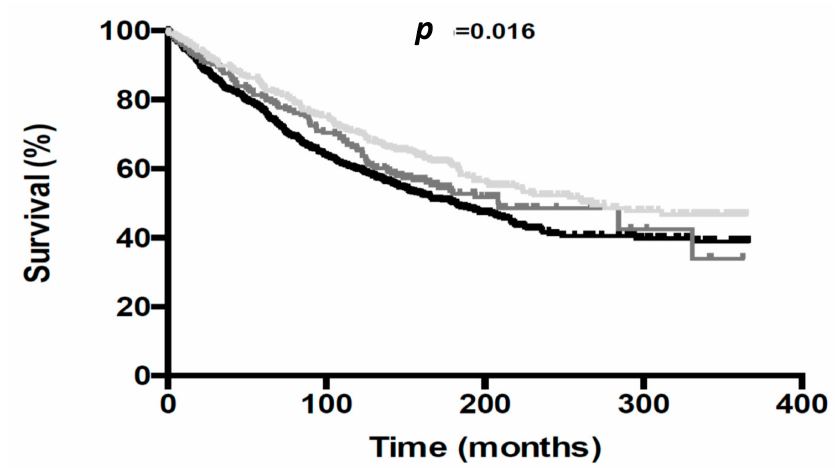
Figure 2. Kaplan–Meier survival curves for all-cause mortality according to glycemic category: normal glucose metabolism (grey line), pre-diabetes (dark grey line) and diabetes (black line).